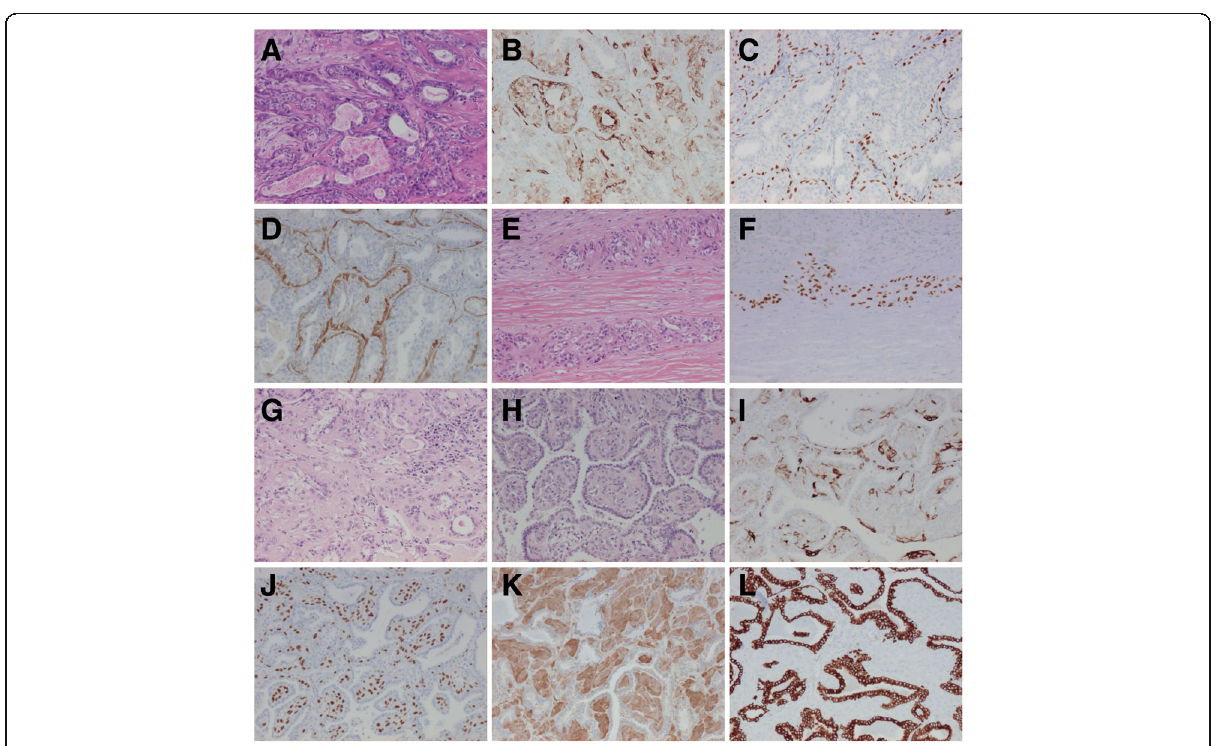
Fig. 2 Case 2. Malignant adenomyoepithelioma in the breast with metastases to the lung. a - f The breast tumour. a HE, ( b ) CK5, ( c ) p40, ( d ) S100, ( e ) HE, peripheral part of the tumour suspicious for invasion, ( f ) p40, peripheral part of the tumour. g - l One of the metastases to the lung. g HE, central part of the tumour, ( h ) HE, peripheral part of the tumour, ( i ) CK5, ( j ) p40, ( k ) S100, ( l ) CK7. Note the CK7-positive reactive alveolar epithelium (positive also for TTF-1, not shown) leading to a papillary appearance at the periphery of the tumour. All images x10